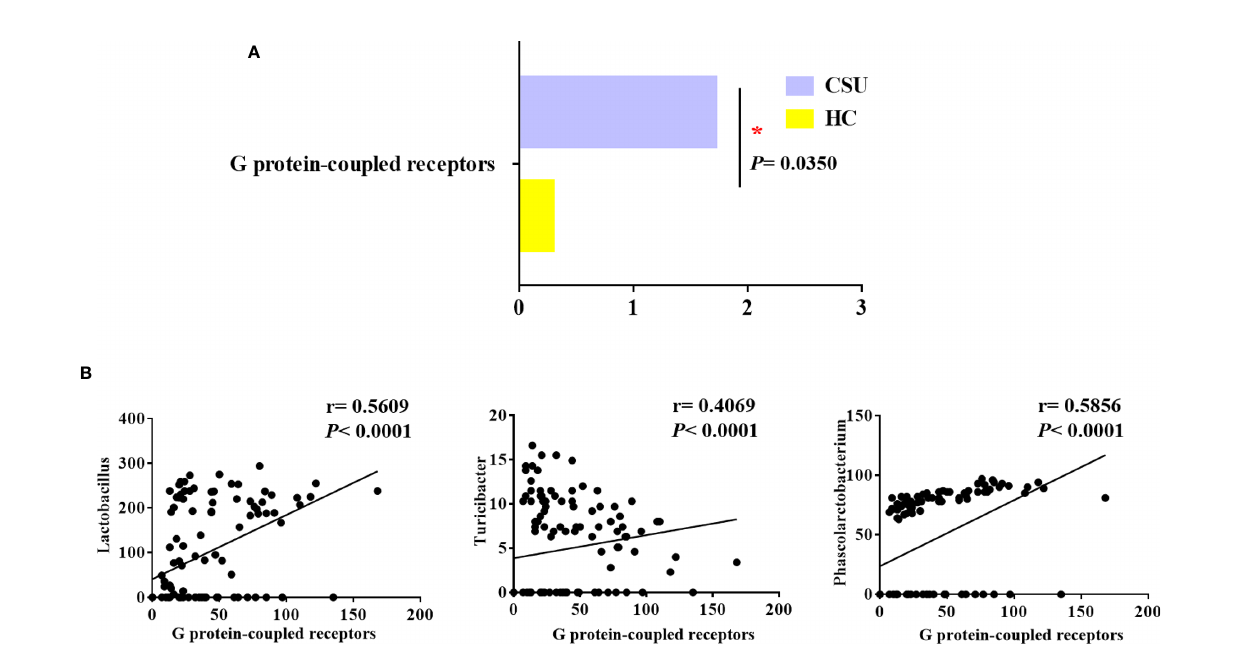
FIGURE 3 | Distinct predicted metabolic pathways between patients with chronic spontaneous urticaria (CSU) and healthy controls (HCs). (A) The signi fi cantly different predicted metabolic pathways between CSU patients and HCs are shown by the Mann – Whitney test (* p < 0.05). (B) Association of the abundance of Lactobacillus , Turicibacter , and Phascolarctobacterium with G protein-coupled receptors. (Spearman ’ s rank correlation coef fi cient, r values, and p -values are